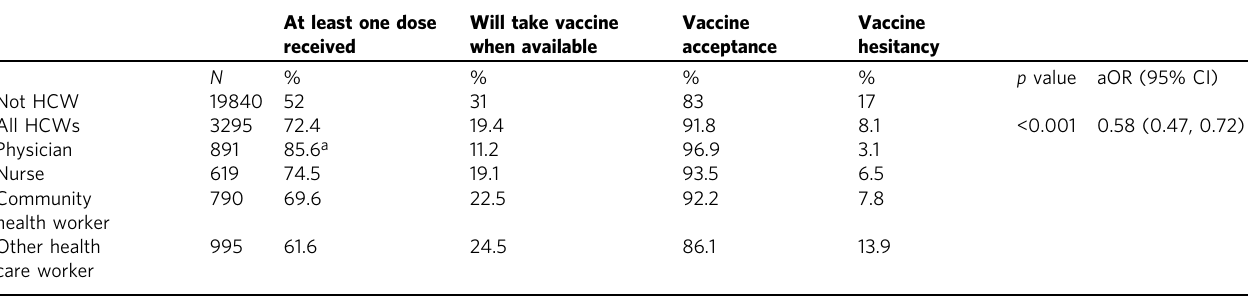
Table 3 COVID-19 vaccine hesitancy and acceptance by health care worker status.